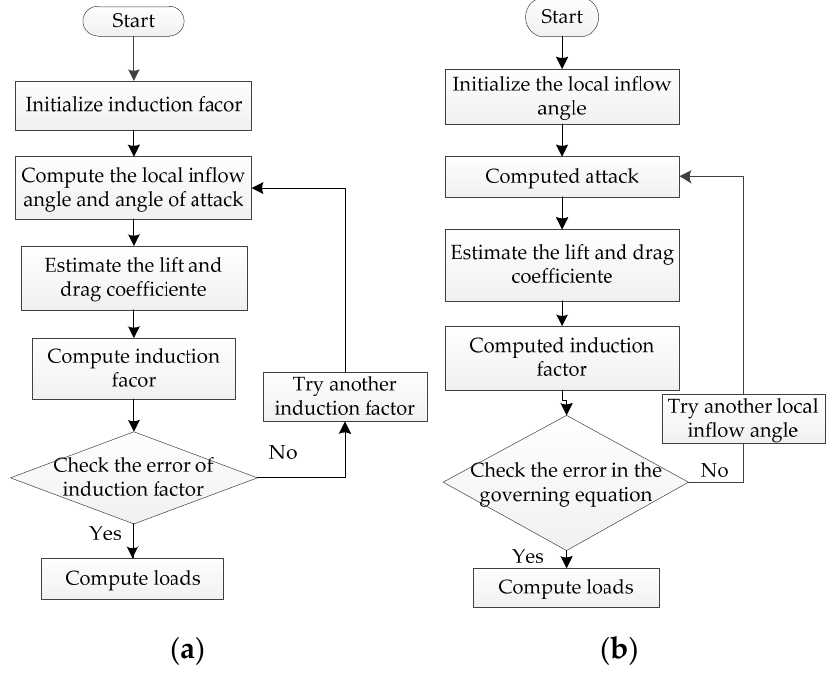
Figure 2. The flowchart of the BEM theory. ( a ) The traditional method. ( b ) Ning’s method.